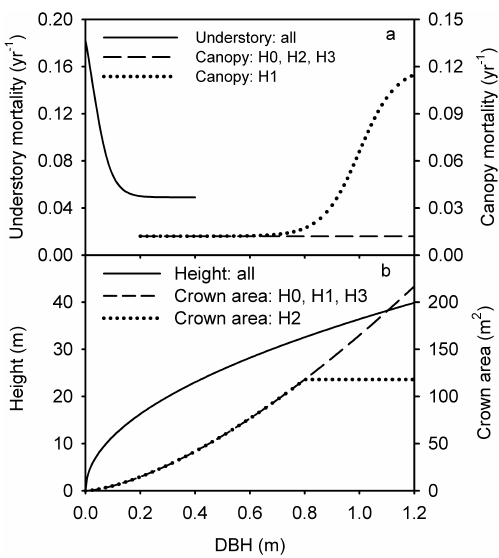
Figure 1. Scaling of mortality rates (a) and tree height and crown area (b) with DBH in four alternative versions of the LM3-PPA model (H0–H3; see Table 2). In panel (a) , the solid line shows the mortality rates of understory trees (same for H0–H3); the dashed line shows the mortality rates of canopy trees in H0, H2, and H3; and the dotted line is for canopy trees in H1. In panel (b) , the solid line is tree height (same for H0–H3); the dashed line shows crown area in H0, H1, and H3; and the dotted line is crown area in